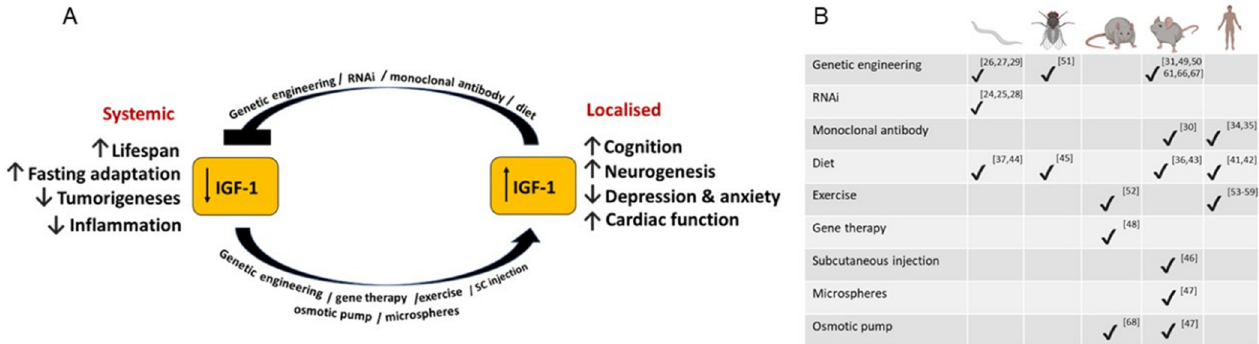
Figure 1. Schematic of IGF1-regulated processes in aging ( A ) and a breakdown of IGF-1-modulating interventions applied to each of the animal models used in the reviewed studies ( B ). Numbers in panel indicate references related to the corresponding interventions in the various model organisms.